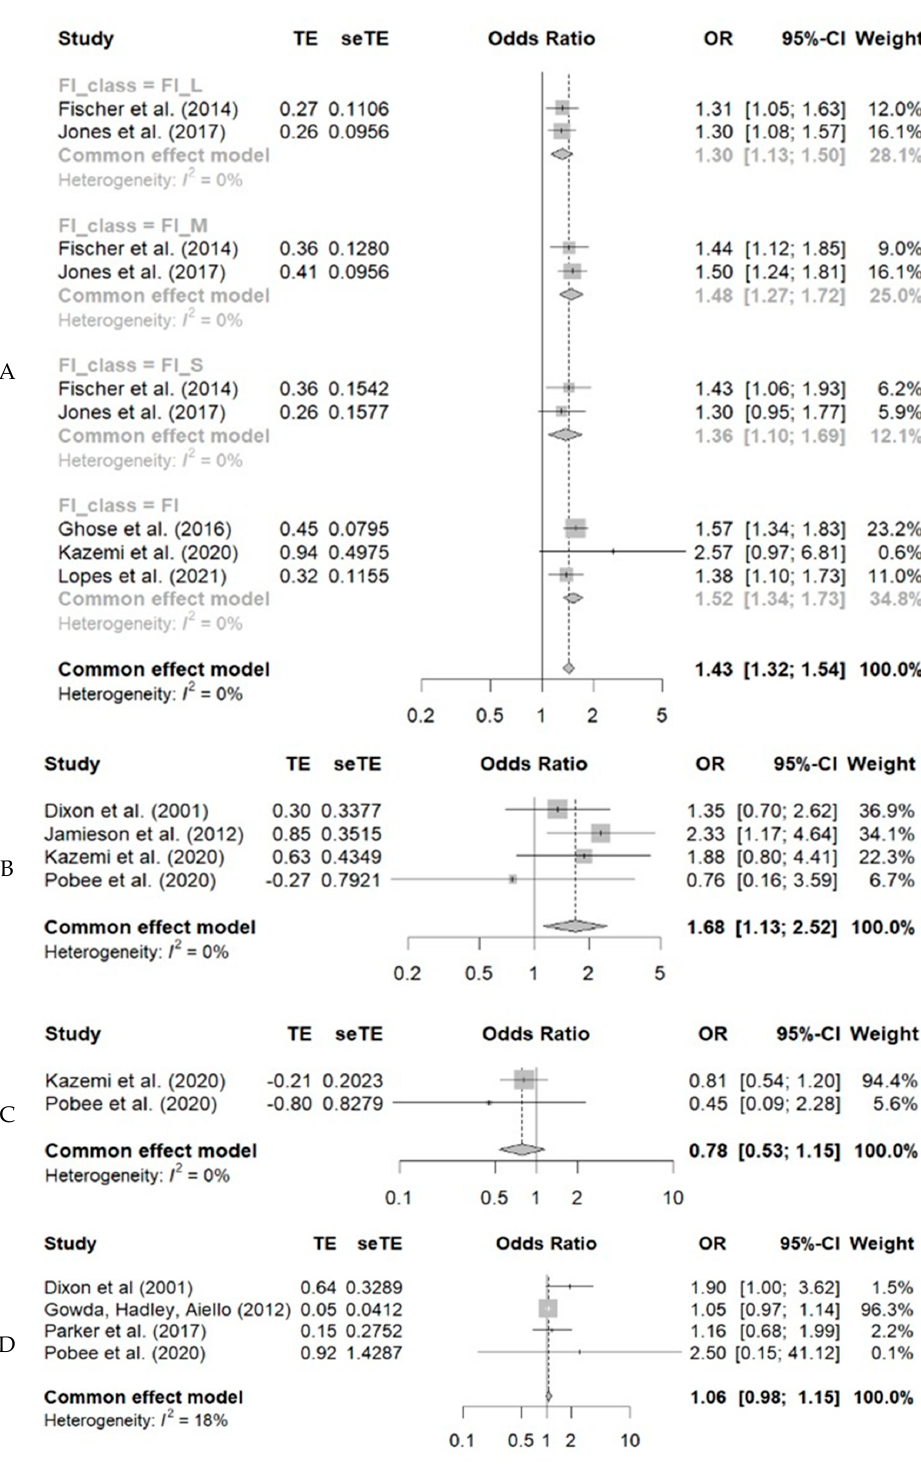
Figure 3. Meta-analysis of the association between food insecurity and anemia ( A ), low ferritin ( B ), vitamin D deficiency ( C ), and vitamin A ( D ) in adult individuals. The greater chance of anemia among individuals in a situation of food insecurity at any level of involvement. Thus, the chances of having anemia were 1.43 (1.34–1.73) higher among the insecure individuals. Individuals with food insecurity were 1.68 (1.13–2.52) times more likely to have low ferritin. For vitamins D and A, no statistical significance was observed